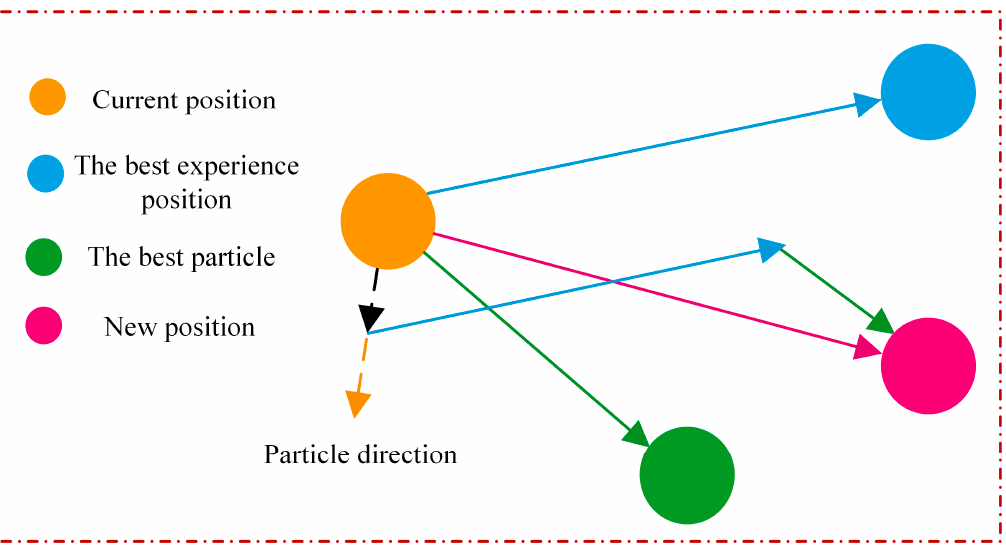
Figure 5. Schematic diagram of the PSO method.